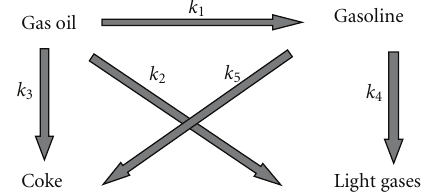
Figure 1: Kinetic scheme of the four-lump reaction model.